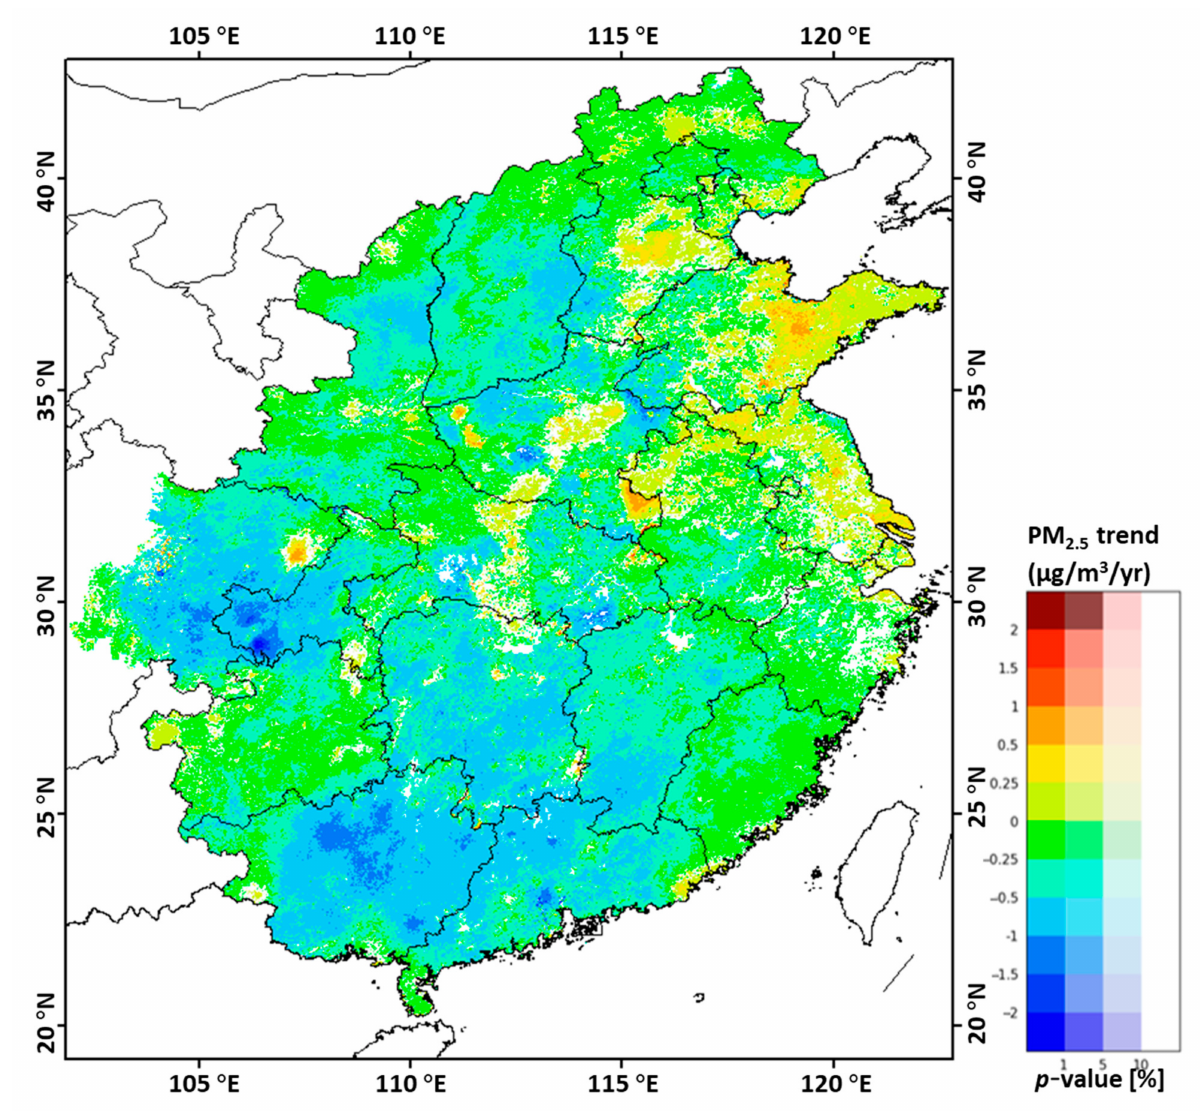
Figure 3. Spatial map of estimated GLS trends based on LOWESS-smoothed monthly time series PM 2.5 from 2001 to 2018. The color of the grid cell represents the slope of the trend, and the transparency of colors stands for the statistical significance level of the